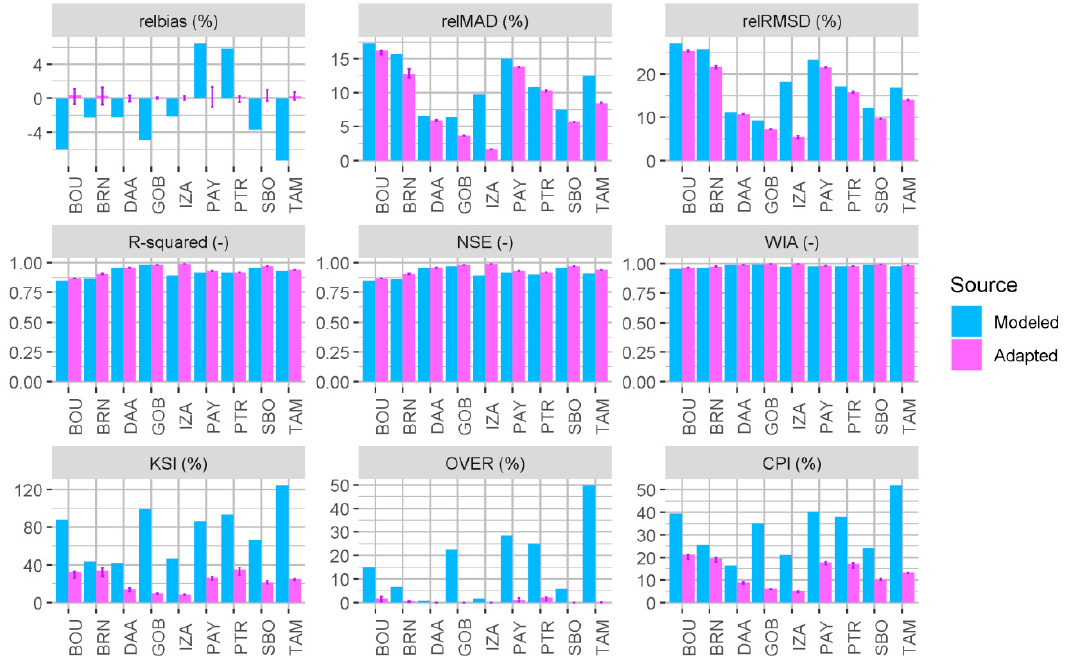
Figure 4. Statistical indicators of modeled and site-adapted GHI.